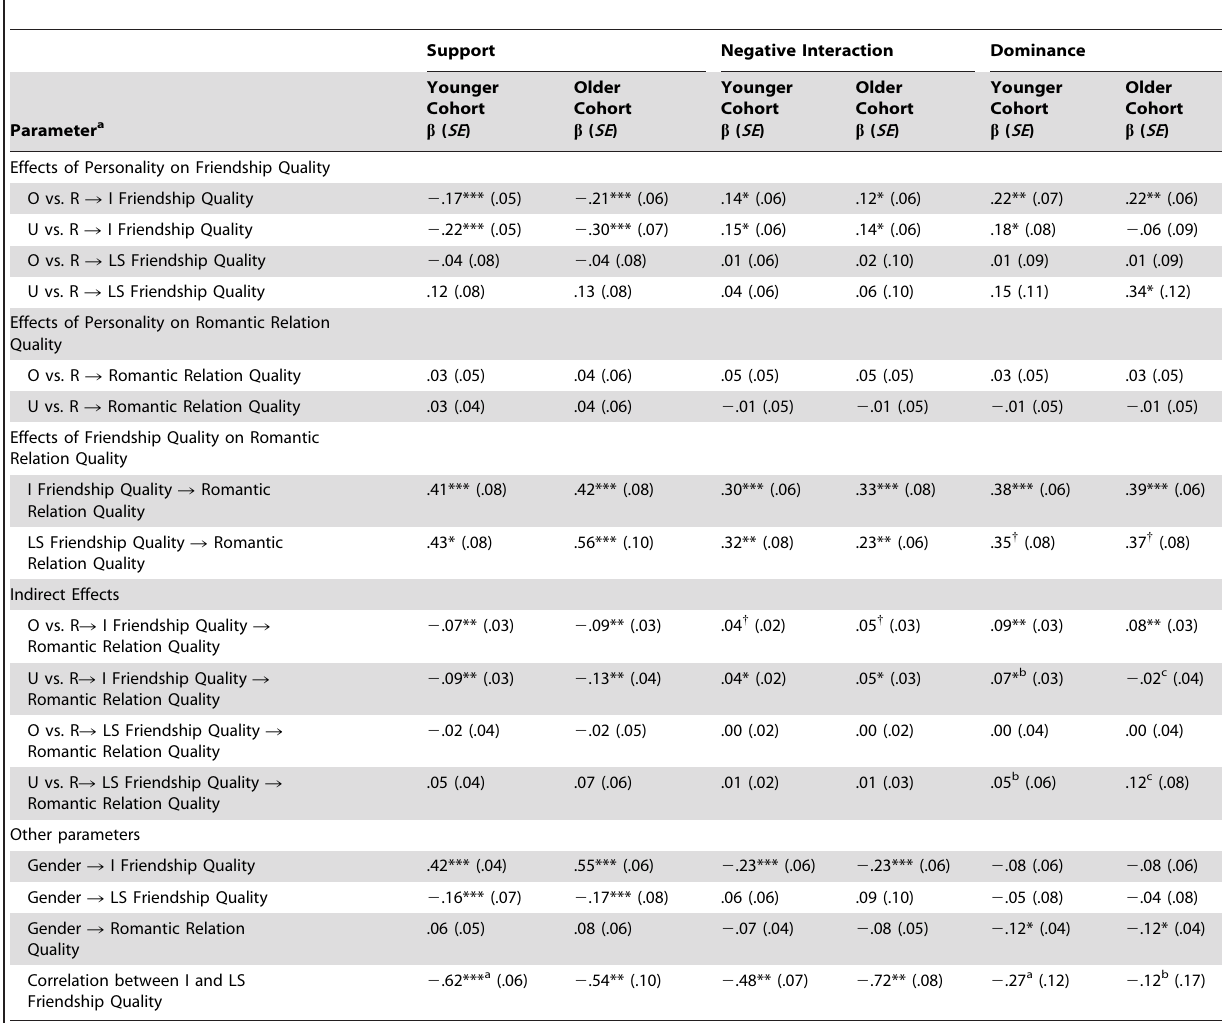
Table 3. Standardized Parameter Estimates of the Structural Part of the Models Testing the Indirect Effect of Adolescent Personality Types on Young Adulthood Romantic Relationship Quality through Development of Friendship Quality throughout